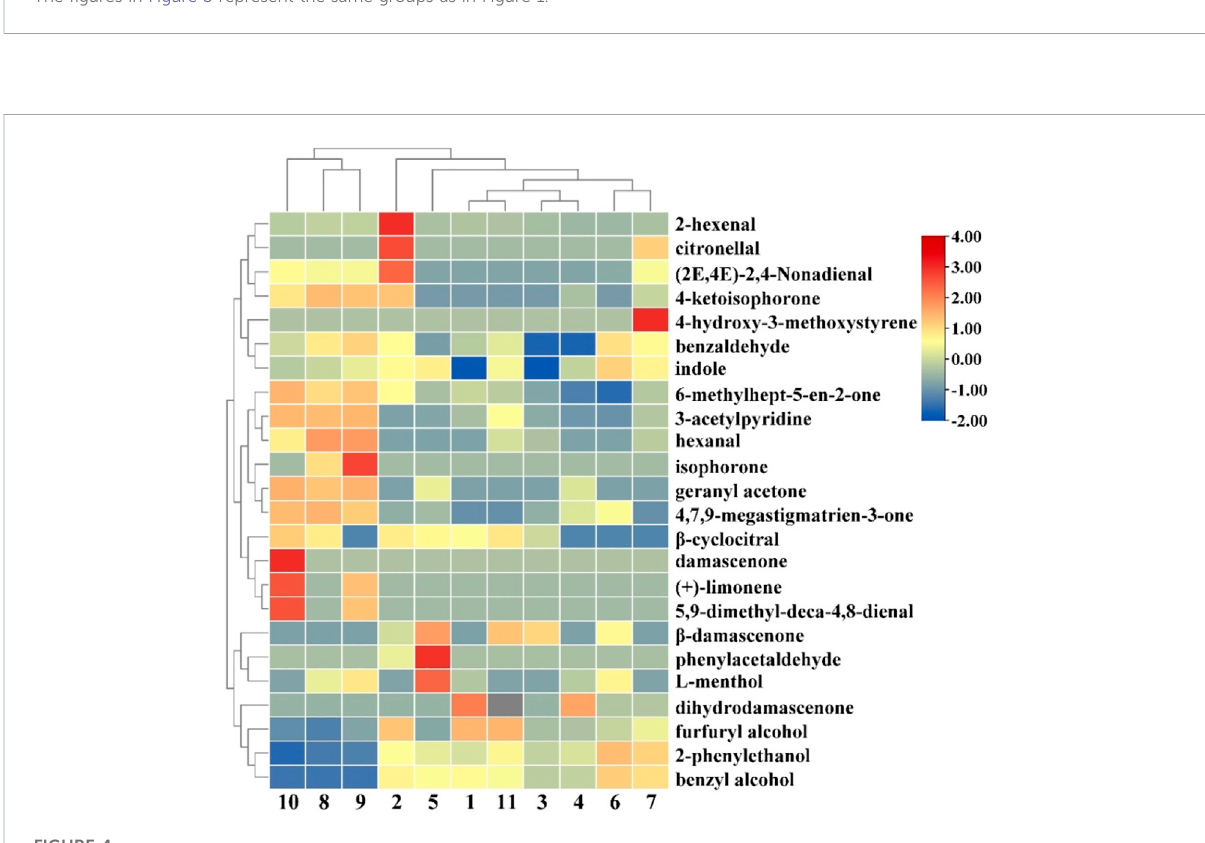
FIGURE 3 Principal componentanalysisbiplot (score and load values) for volatile compounds indifferenttreatmentof fermented Cigar fi ller leaves. Note: The fi gures in Figure 3 represent the same groups as in Figure